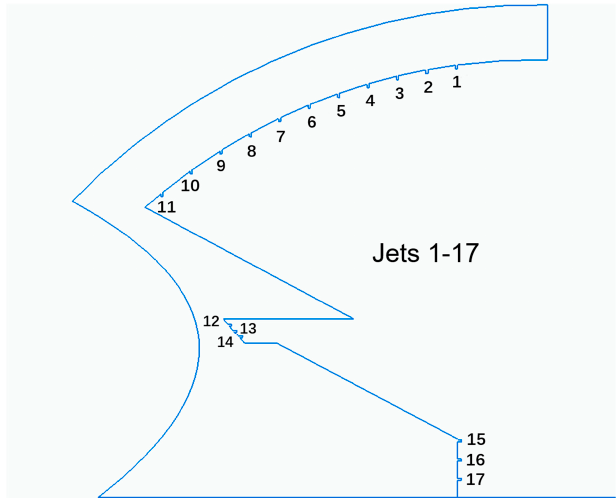
Figure 5. The cooling jets configuration used for cooling configurations 1 and 2. Table 3. Cooling scenarios under each cooling configuration.